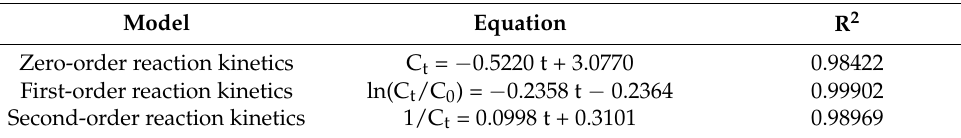
Figure 10. ( a ) The e ff ect of photocatalytic time on the photocatalysis of MM-CaTiO 3 . ( b ) Zero-order reaction kinetics, ( c ) fi rst-order reaction kinetics, and (d) second-order reaction kinetics. Table 3. Kinetic reaction model and correlation of photocatalytic degradation. Table 3. Kinetic reaction model and correlation of photocatalytic